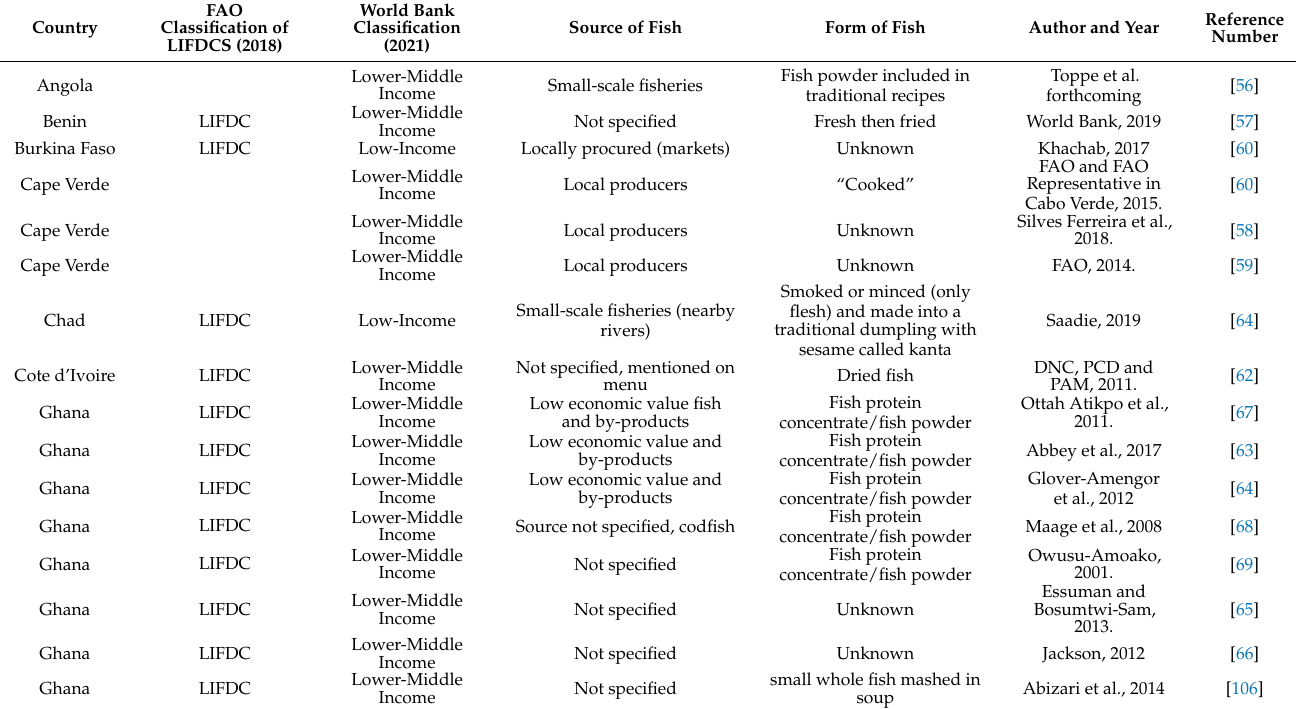
Table A1. Summary table of records included in the review, including FAO and World Bank country classifications, source and form of